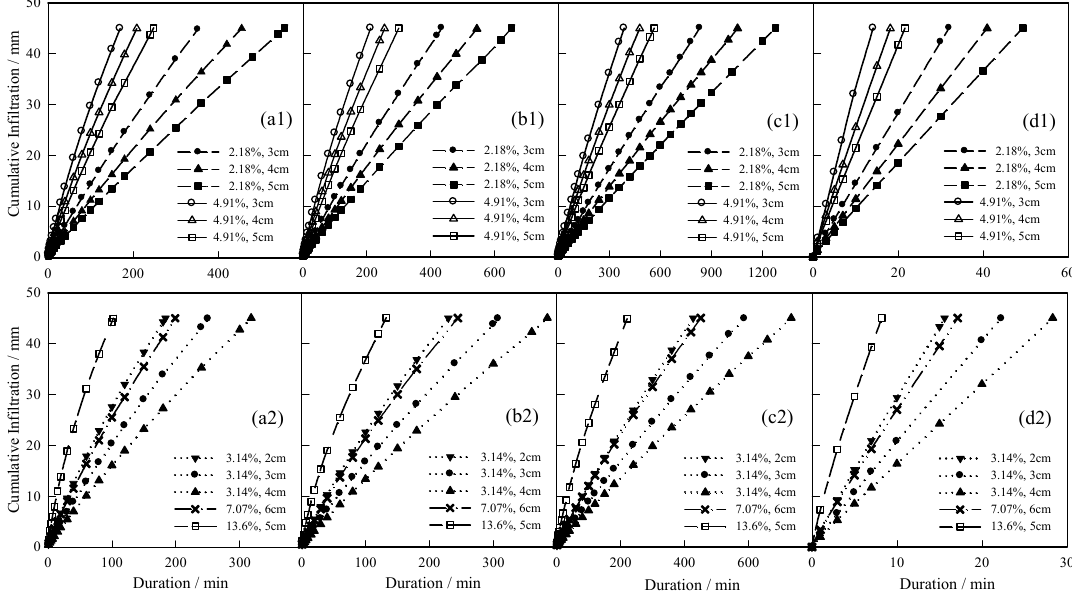
Figure 9. Infiltration pattern curve under different film hole spacing: ( a1 , a2 ) silt loam, γ d = 1.30 g · cm − 3 ; ( b1 , b2 ) sandy loam, γ d = 1.45 g · cm − 3 ; ( c1 , c2 ) loam; and ( d1 , d2 ) sand. In the legend, the percentage values are equal to ρ , and the following values are equal to D .